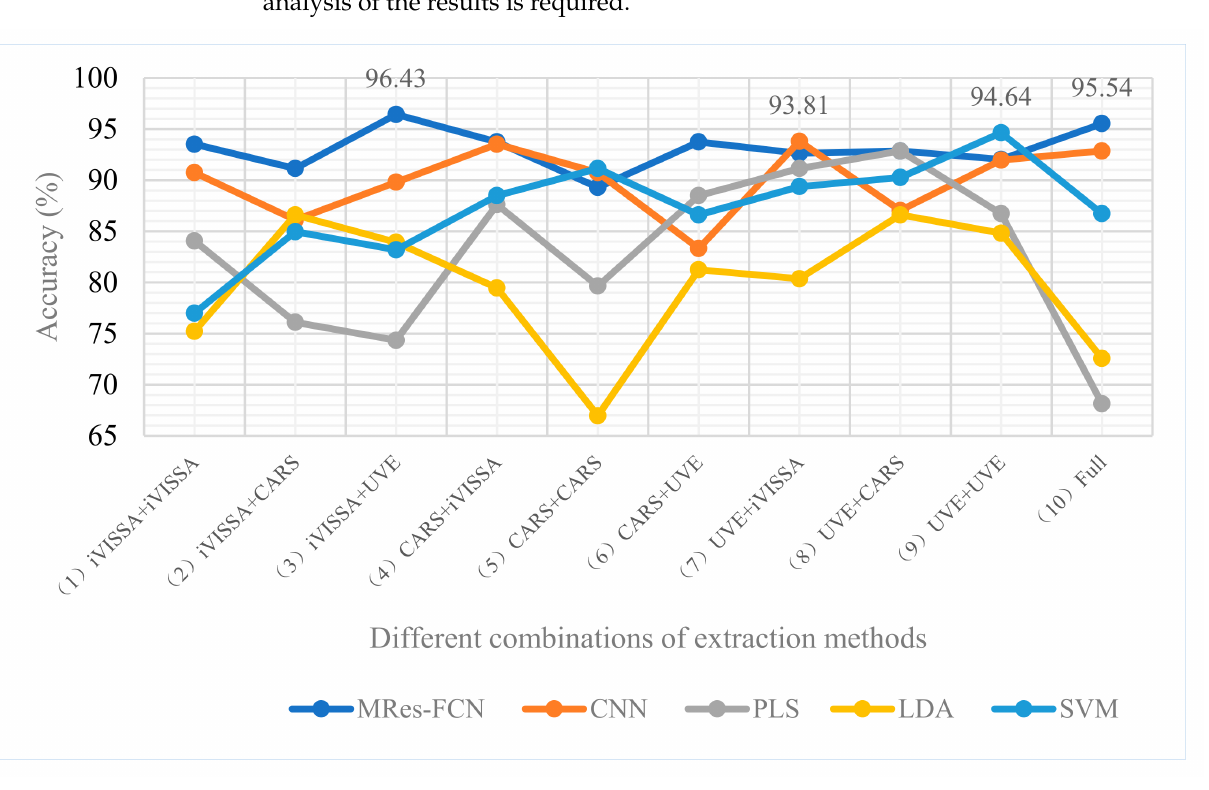
Figure 10. The classification results after extracting the characteristic wavelengths of the two spectral ranges, respectively. Different combined extraction methods were marked with 1 to